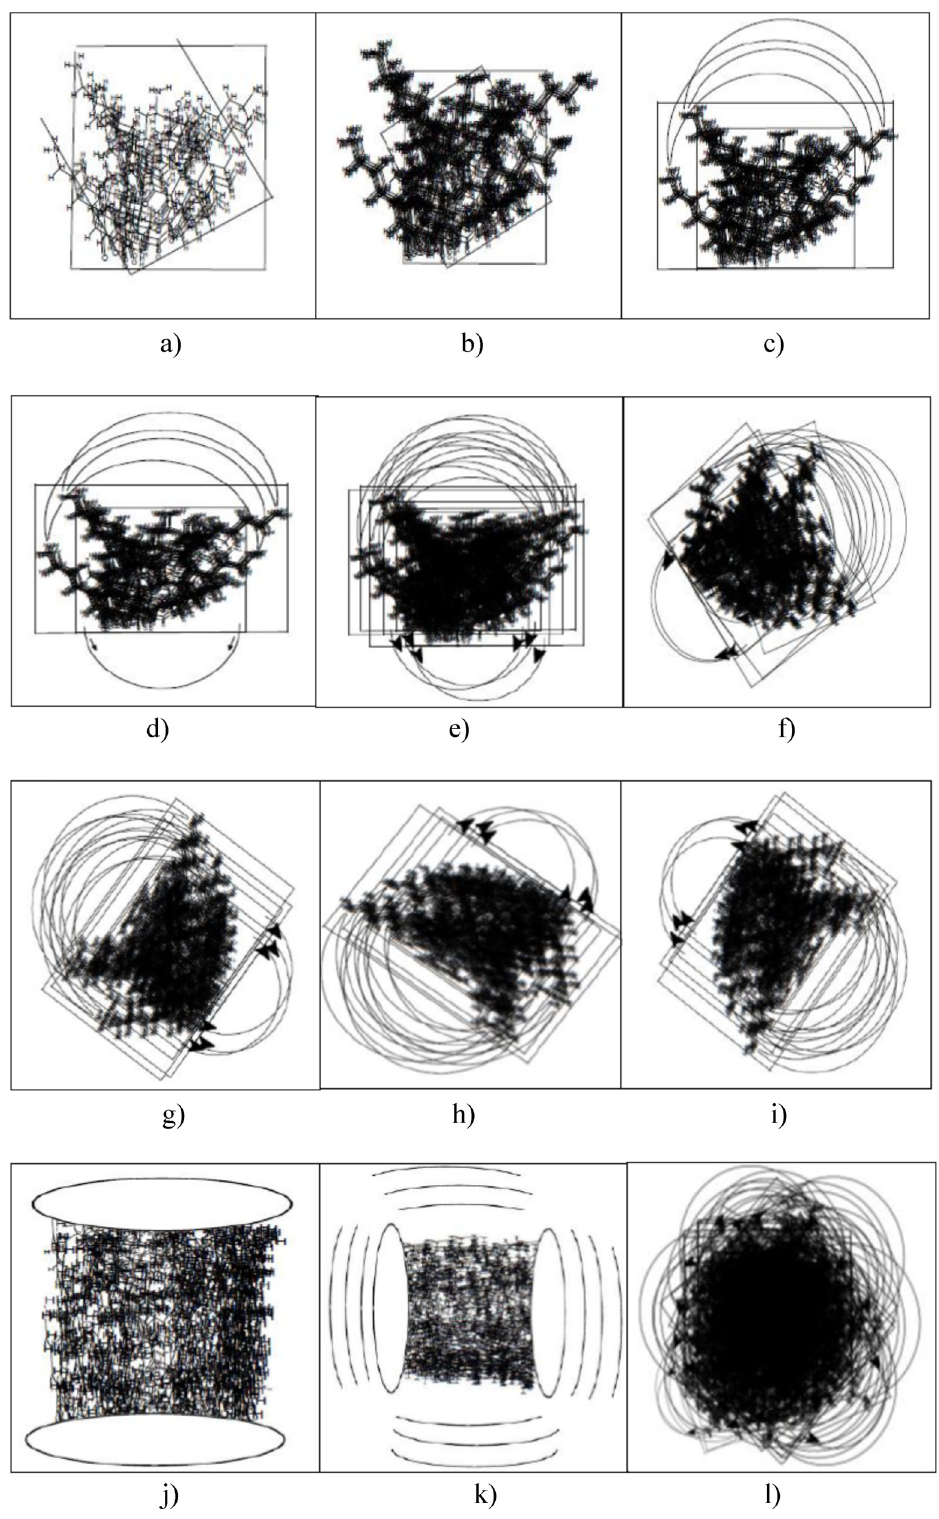
Figure 13: Plausible approach to nano - vesiculation; ( a ) surface interaction; ( b ) interfacial activity; ( c ) single - dimension interaction; ( d ) another dimension based interaction and structural motifs assembly; ( e ) increased interaction; ( f ) twisting of the structural motifs ’ direction; ( g – i ) multi - directional increased movements and interactions; ( j ) lateral compression of the assembled structural motifs; ( k ) compression leading to volume reduction, and counter - compression yielding to increased interfacial interactions, and further compression and reduction of volume; ( l ) formation of a prototypical nano - vesicle, entrapping ions, water molecule, and small molecular weight